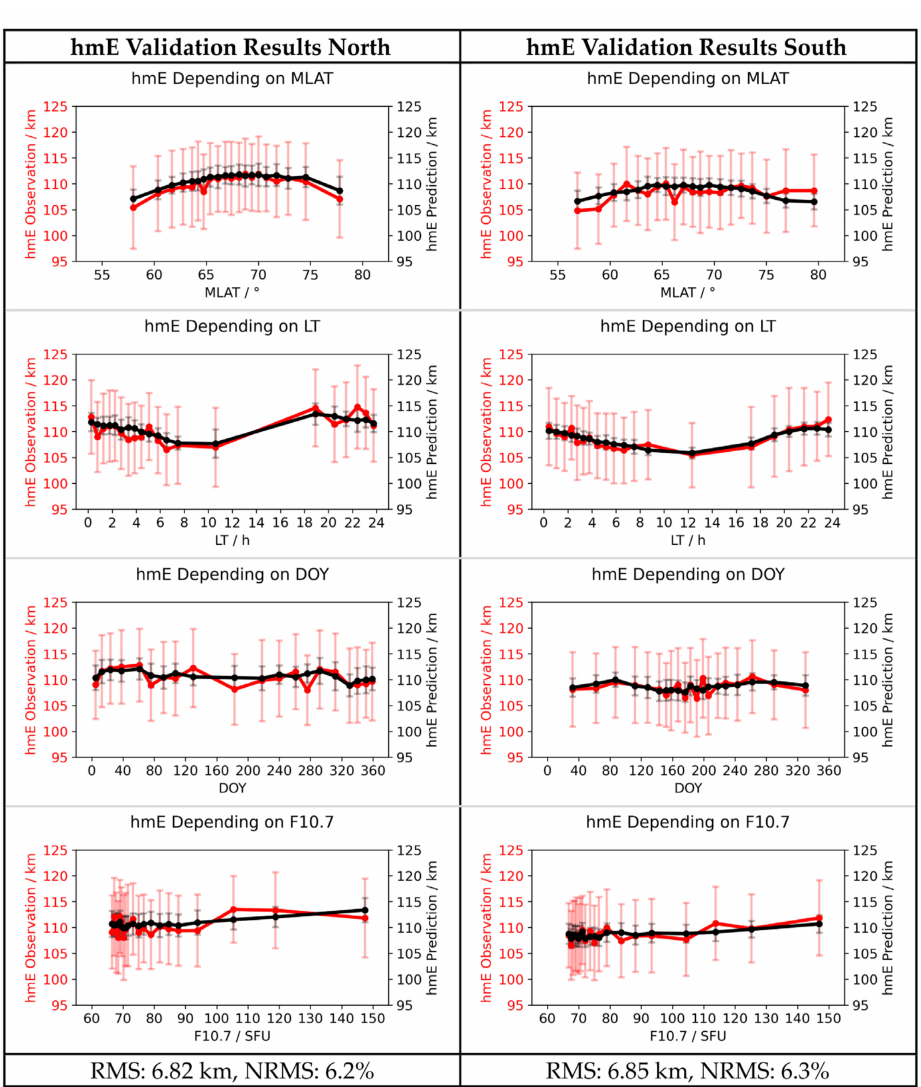
Figure 7. Observed (red) and predicted (black) hmE trends for the test dataset. ( Left ) Northern Hemi- sphere. ( Right ) Southern Hemisphere. Last row: RMS and NRMS deviation between observation and